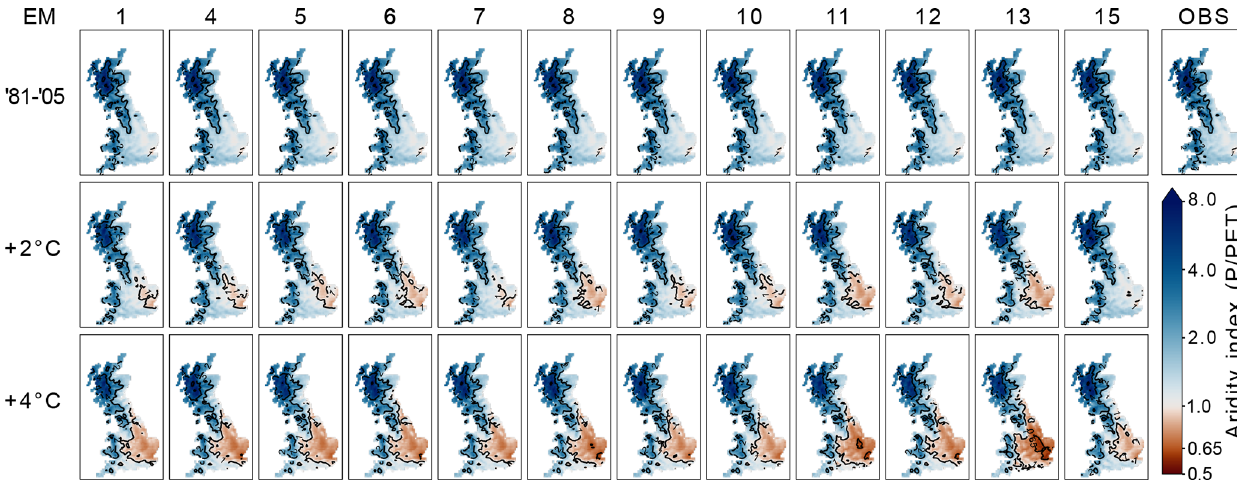
Figure 3. Aridity index (average annual P/ PET) for the 12 bias-adjusted UKCP18 RCM ensemble members. The contours shown in black are powers of 2 and the level of 0.65 (below which a climate is classified as dry